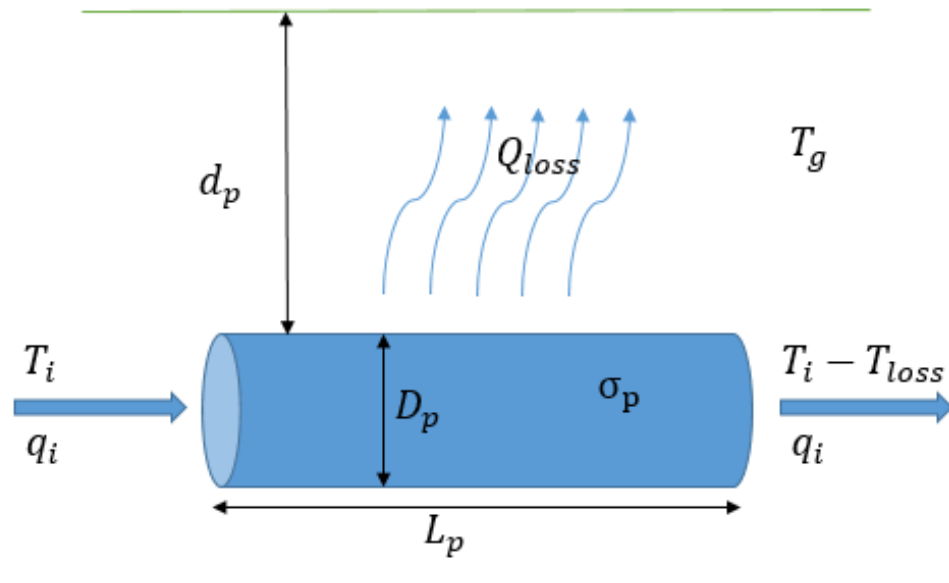
Figure 3. Pipe heat loss with related parameters and